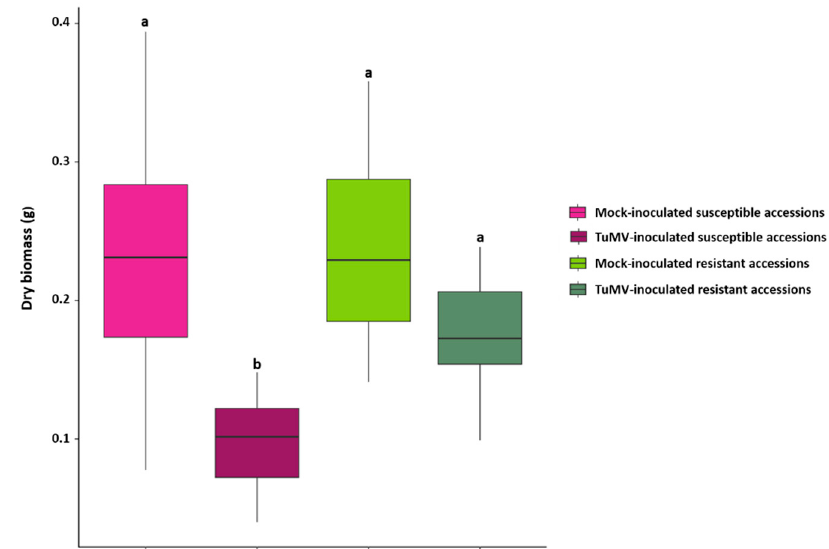
Figure 1. Above ground Dry biomass for mock-inoculated and TuMV-inoculated susceptible and resistant accessions measured at 13 days after inoculation (dai) on 26 accessions in the ‘2015 ′ field experiment. Statistical comparisons (Kruskal-Wallis test) on dry biomass were performed between all categories of accessions (N = 21 for Mock and inoculated susceptible categories; N = 8 for mock and inoculated resistant categories). Plots with the same letter are not significantly different at p = 0.05.